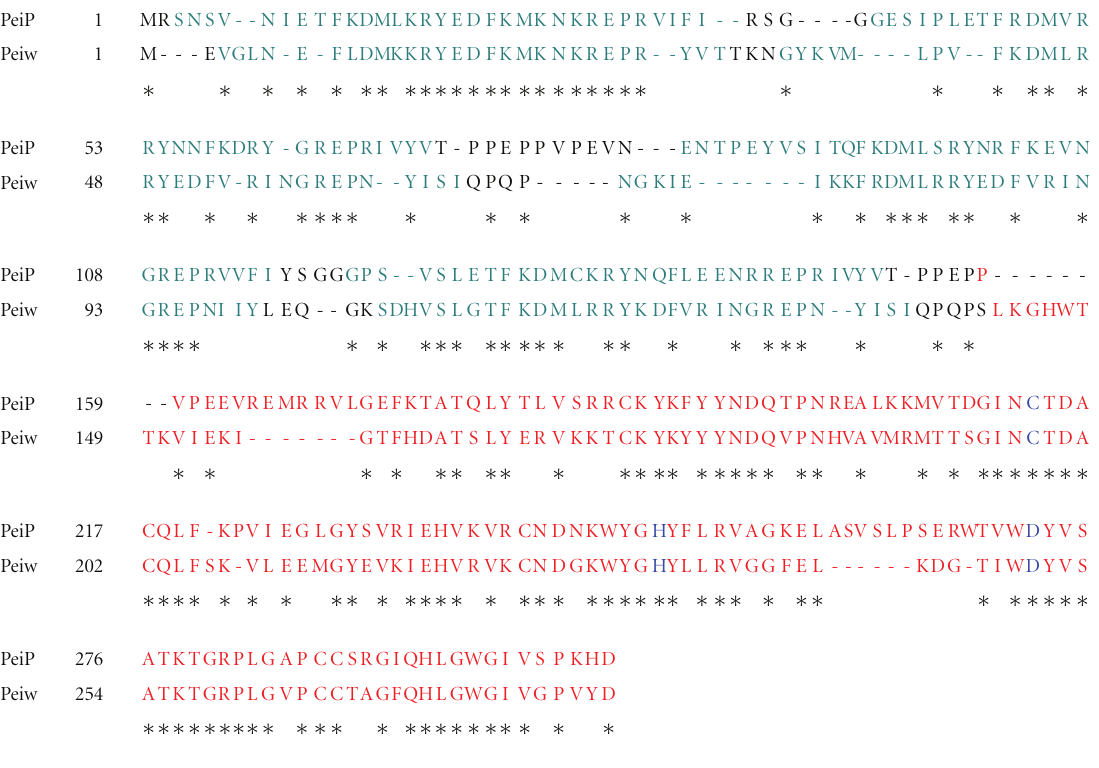
Figure 2: Protein sequence alignment of the pseudomurein endoisopeptidases PeiP and PeiW. The picture was generated with the SIM program of the ExPASy proteomics server (http://expasy.org/tools/sim-prot.html). N-terminal direct repeats in the pseudomurein binding repeat domain are shown in green, and the C-terminal catalytic domain is presented in red. The catalytic triad C-H-D is indicated in blue. ∗ indicates identical amino acid residues in PeiP and